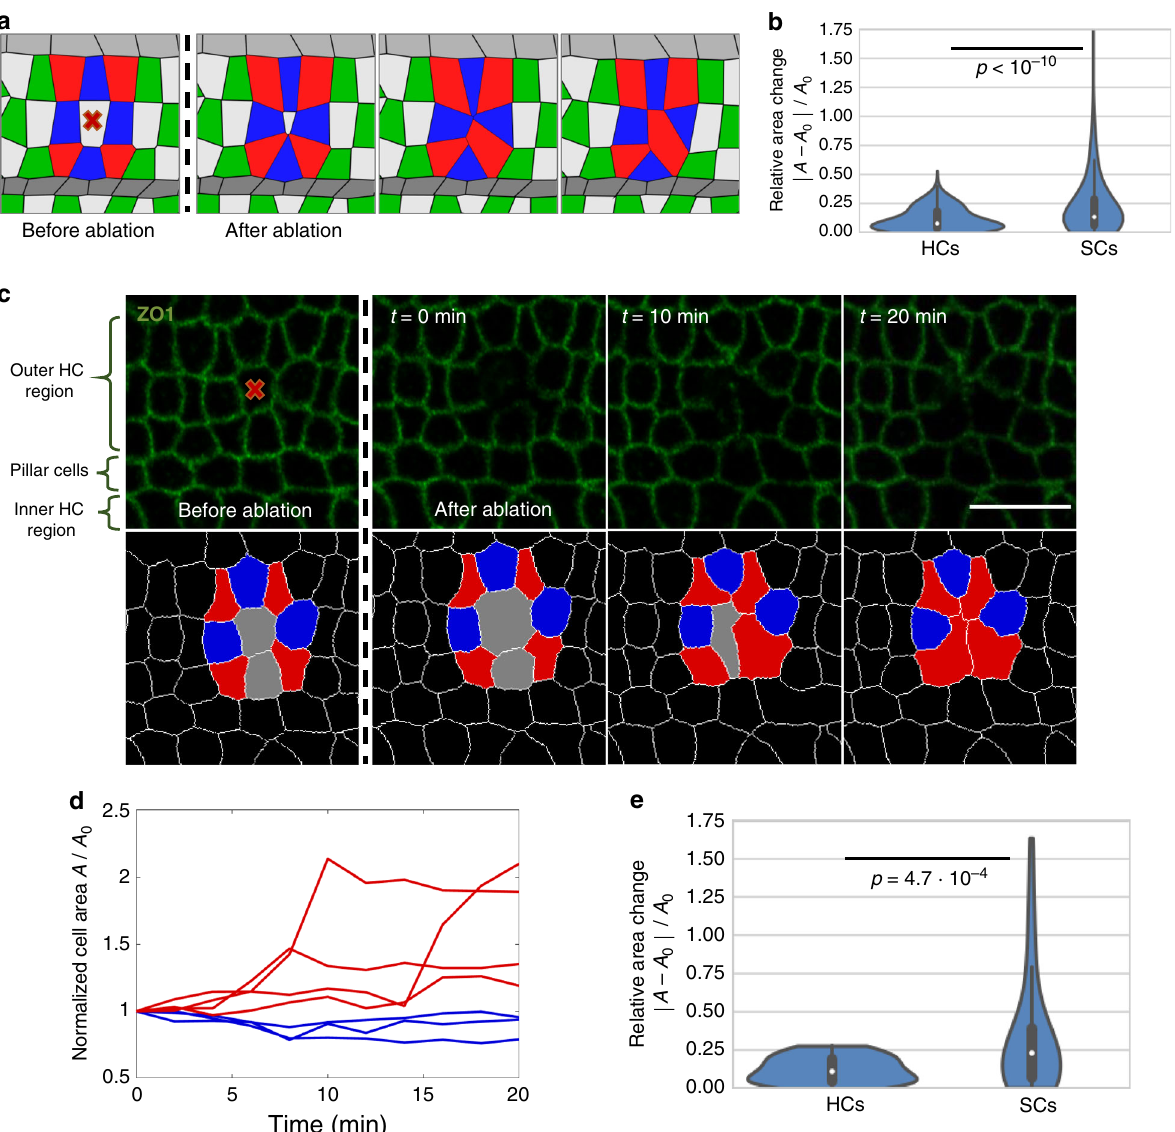
Fig. 4 Laser ablation experiments show that SCs are more deformable than HCs. a A fi lmstrip of a simulation modeling cell ablation (ablated cell marked with red “ x ” ). Surrounding HCs (blue) and SCs (red) are marked. Movie shown in Supplementary Video 11. b Violin plot of the distributions of the relative change in area of HCs and SCs surrounding the ablated cells in the simulation. The presented data is taken from n = 825 simulations. c A fi lmstrip from a E17.5 ZO1-EGFP explant showing a laser ablation experiment. Ablation point is marked by red “ x ” . Bottom row shows a segmented version of the fi lmstrip with ablated area (gray), nearest neighbors HCs (blue), and nearest neighbor SCs (red) marked. Movie shown in Supplementary Video 12. Scale bar: 10 μ m. d Normalized area of the cells shown in c . The area of each cell is normalized by its initial area before the ablation. e Violin plot of the distributions of the relative change in area of HCs and SCs, 10 min after ablation. The presented data is taken from n = 10 experiments. In the violin plots in b , e , median is indicated by white point, interquartile range (IQR) is indicated by thick line, Q3 + IQR and Q1 − IQR are indicated by the edges of the thin line and kernel density estimate of the data is shown in blue. In both plots, the p -value from two-tailed Kolmogorov – Smirnov test is as anti-rabbit Alexa Fluor 594 (Cell signaling, Cat: 8889, Lot: 7) for 2h at room temperature. Stained samples were mounted on Cover glass 24x60mm thick. #1 (0.13-0.17 mm) slides (Bar-Naor Ltd. cat: BN1052441C) using a fl uorescent mounting medium (GBI, cat: E18-18). Image acquisition was done with a ZEISS LSM 880 with Airyscan microscope (Zeiss).